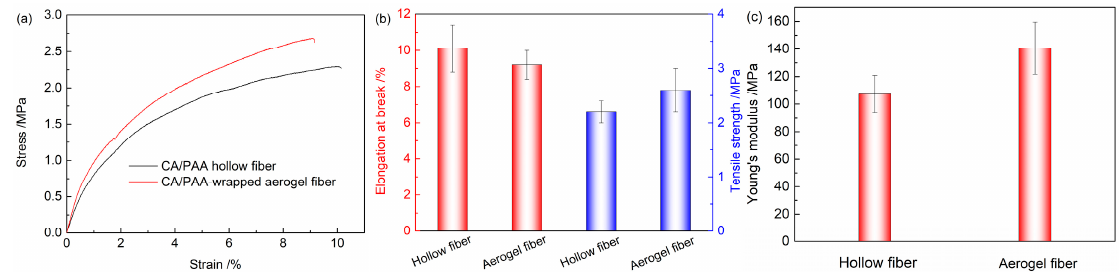
Figure 4. Mechanical properties of CA/PAA hollow fiber and CA/PAA-wrapped SF aerogel fiber: ( a ) stress-strain curve; ( b ) elongation at break and tensile strength; ( c ) Young’s modulus.